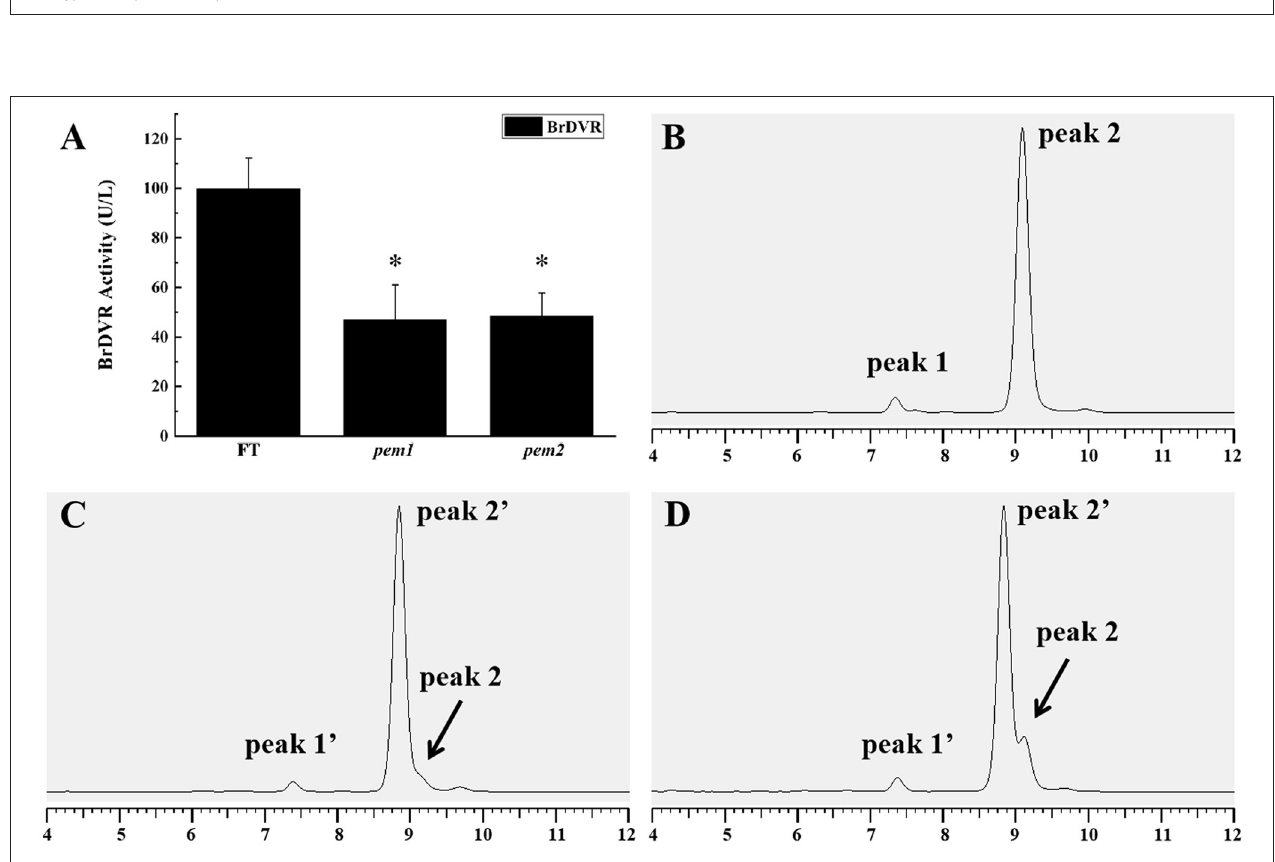
FIGURE 8 | DVR activity assay and chlorophyll composition analysis among the wild-type “FT,” pem1 and pem2 . (A) DVR activity of “FT” and pem1 and pem2 . The asterisk represents significance. Chlorophyll composition analysis by HPLC: wild-type “FT” (B) , pem1 (C) , pem2 (D) . Peak 1, chlorophyll b; peak 2, chlorophyll a, peak 1 ′ , chlorophyll b-like; peak 2 ′ , chlorophyll a-like. The abscissa axis is the elution time.